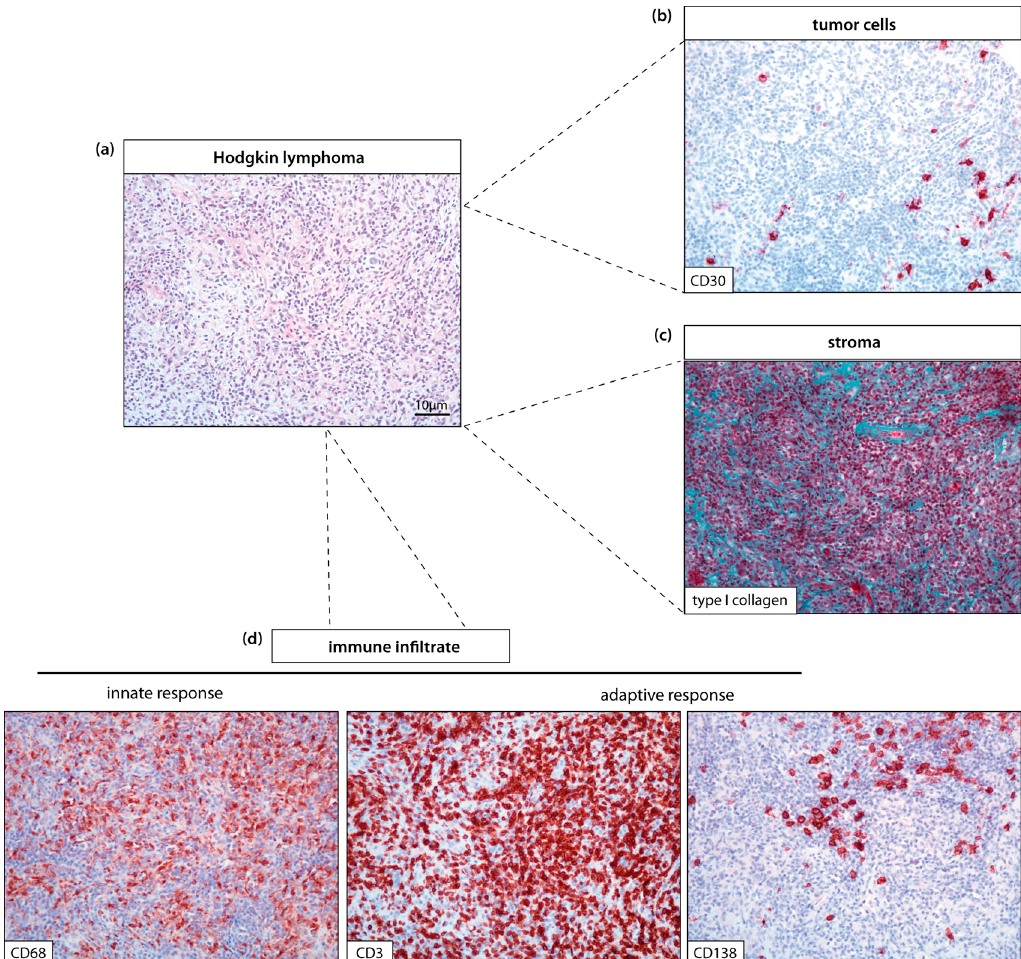
Figure 1. Hodgkin lymphoma is a clear example of a neoplasm where the components of the TME largely exceed the number of tumor cells. The differential staining of the histological sections corresponds to the same field of the tumor, showing overlapping layers that reveal a heterogeneous composition of the TME. ( a ) H&E staining of Hodgkin lymphoma. ( b ) little proportion of CD30 positive lymphoma tumoral cells. ( c ) Masson’s trichrome stain of abundant type I collagen (blue) and ( d ) representation of the host innate immune response via macrophage infiltrate (CD68) and the adaptive cellular response mediated by T cells (CD3) and B cells secreting antibodies against the tumor (CD138). Among others, this example constitutes the complex immune and stromal response that determines the histology, response to treatment, and tumor prognosis.